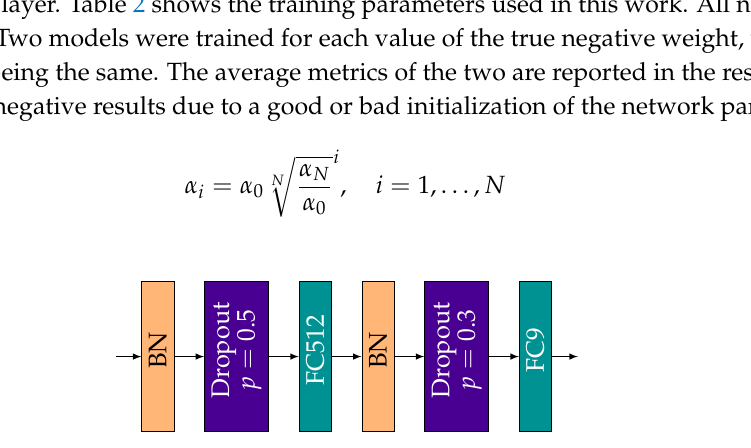
Figure 4. Network head used in all experiments. This is inserted in place of the original fully connected layer to adapt the network to the data. The fully connected layers include a ReLU activation. In the figure, BN is a batch normalization layer [33], FC is a fully connected layer, and Dropout is a dropout layer [34].